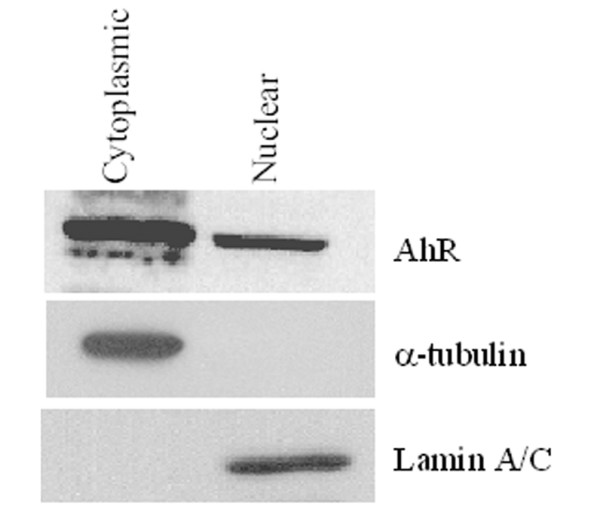
Hs578T cells express nuclear aryl hydrocarbon receptor (AhR). Cytoplasmic and nuclear cell extracts prepared from subconfluent monolayers of malignant, estrogen receptor negative Hs578T cells were analyzed by western immunoblotting with AhR-specific antibody following SDS-PAGE. Blots were stripped and re-probed for lamin A/C and α-tubulin to confirm purity of the nuclear and cytoplasmic cell fractions, respectively. Representative data from a total of three experiments are shown.